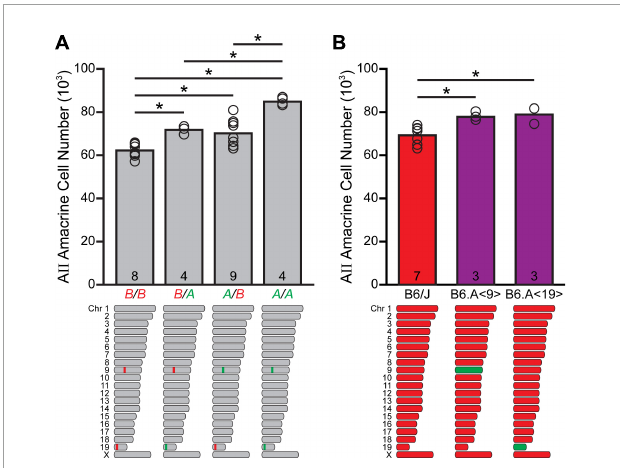
FIGURE3 The quantitative trait loci (QTLs) on Chr 9 and Chr 19 are additive in their effects upon AII amacrine cell number. (A) The four recombinant inbred (RI) strains harboring the A haplotype at both loci have, on average, ∼ 84,000 AII amacrine cells, whereas the seven RI strains containing the B haplotype at both loci have ∼ 62,000 cells. Strains having A at one locus and B at the other locus contain intermediate numbers of AII amacrine cells. n = the number of RI strains with each haplotype combination at the respective loci on Chr 9 and 19. (B) Chromosome substitution strain mice, bearing the A haplotype for Chr 9 or Chr 19 introgressed upon a B6/J genetic background, each contained roughly 9,000–10,000 more AII amacrine cells than did B6/J mice. n = the number of retinas